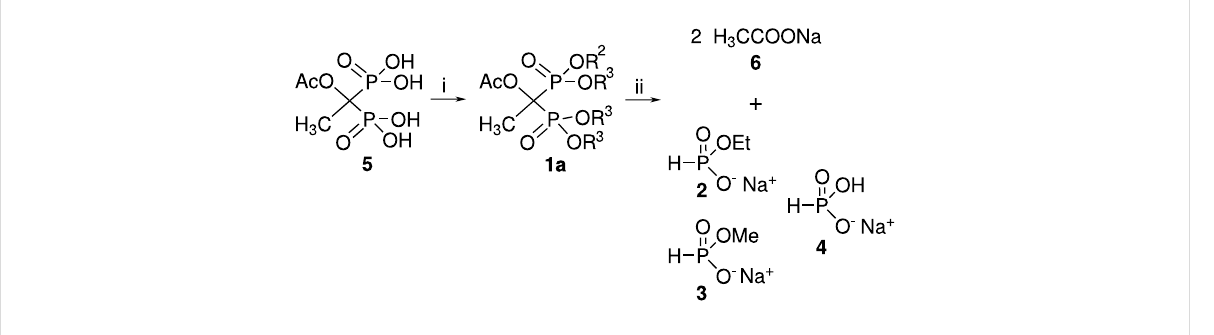
NaOH) and before the degradation of P-C-P bridge, 3)